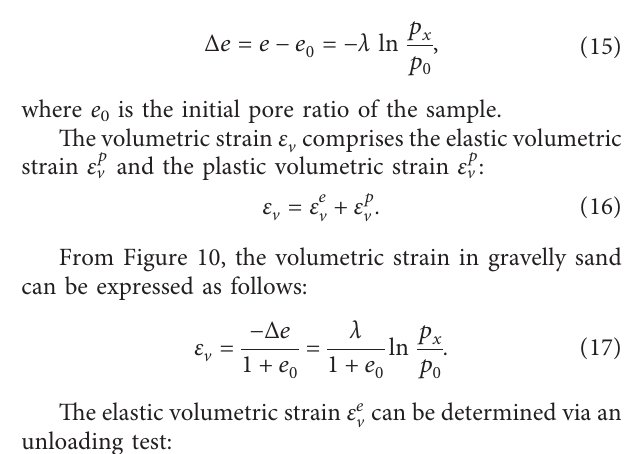
Figure 8: Effects of the material parameters s and t on the higher-order yield function. (a) s -higher-order yield function ( D σ 3 � 50kPa, M � 1.37, and t � 0.75). (b) t -higher-order yield function ( D r � 0.55, σ 3 � 50 kPa, M � 1.4, and t � 2).